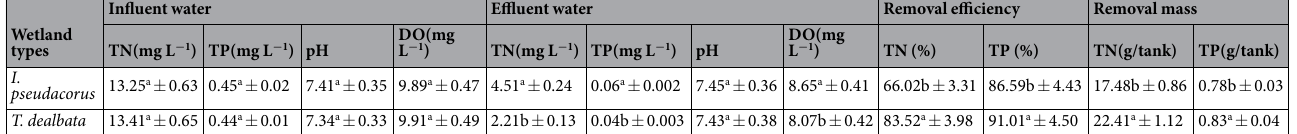
Table 1. Mean concentration of total nitrogen (TN) and total phosphorus (TP) (mean ± SD, n = 3) of the influent water and effluent water in the FTWs, and mean removal efficiencies/mass in 32 batches. Note: Values with different superscript letters in the same column for the two treatments indicate a significant difference at P < 0.05 according to Duncan’s multiple range test.